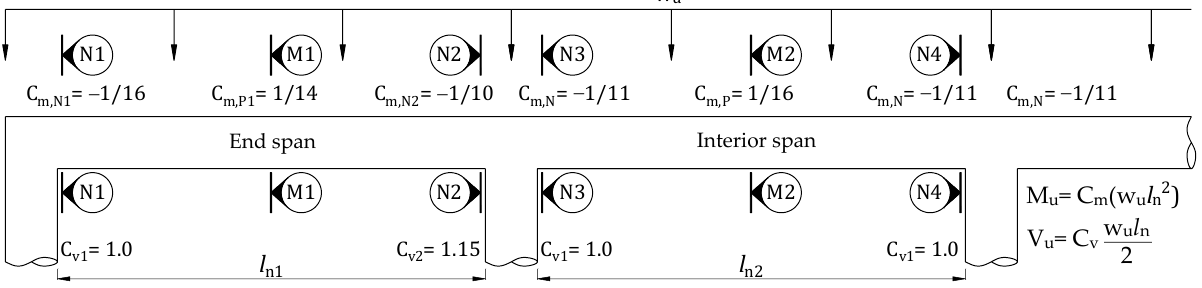
Figure 2. Approximate coefficients for estimating moments and shears of flexural members on continuous slabs with column supports in accordance with ACI 318M.